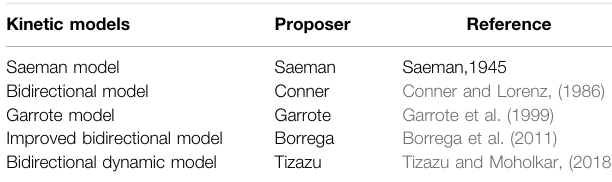
TABLE 2 | The development summary of kinetic models during hemicellulose